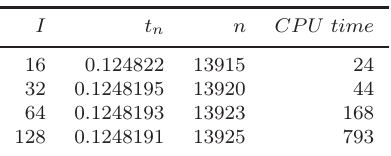
Table 4. The implicit Euler method for ε = 1 / 100 .